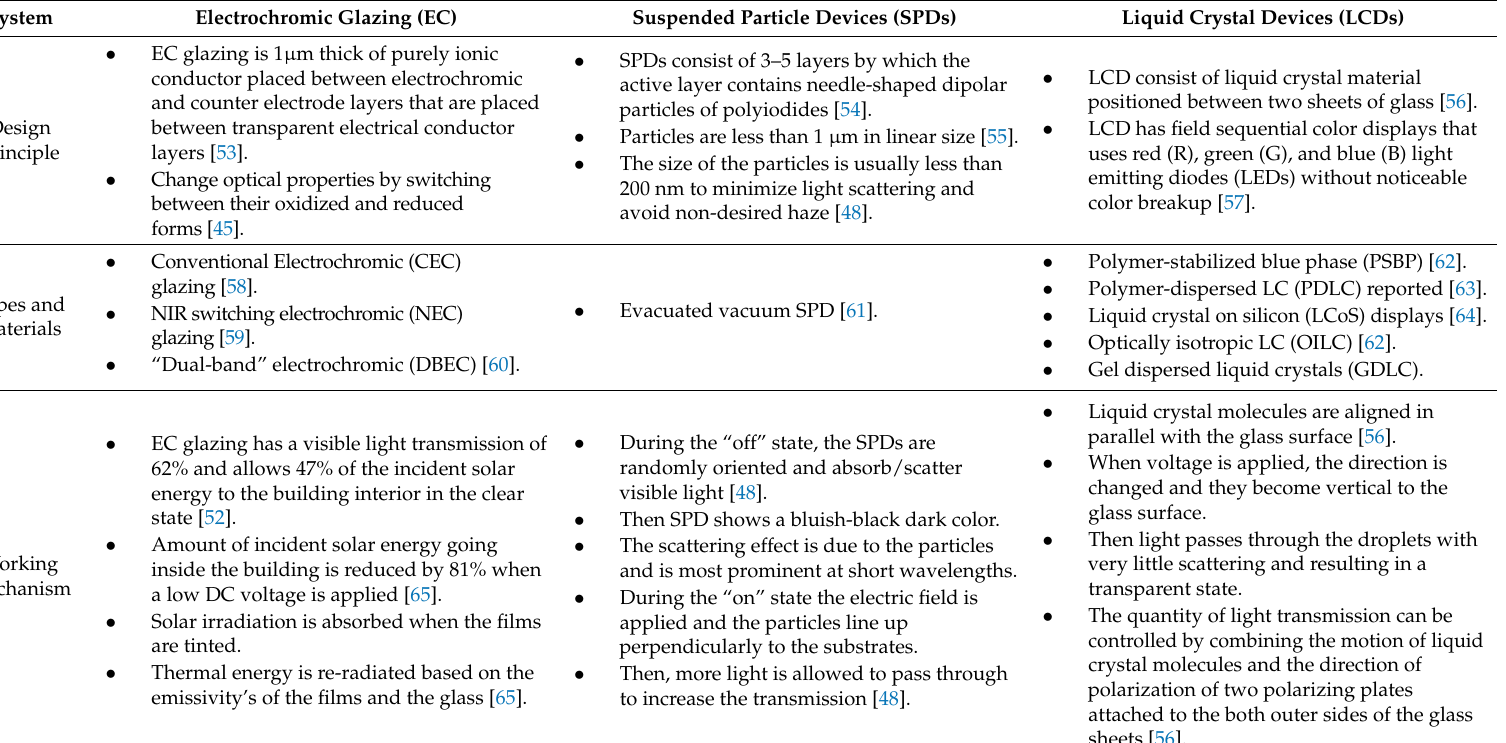
Table 1. Summary of smart glazing